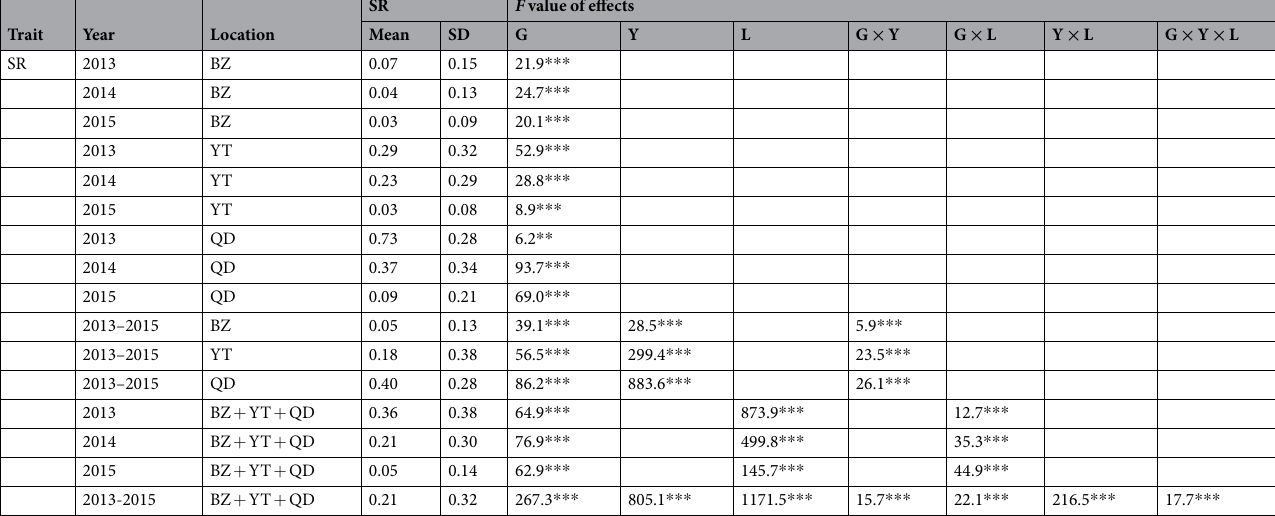
Table 1. Summary of the analysis of variance (ANOVA) of frost tolerance in pea across Binzhou, Yantai and Qingdao, Shandong province, China from 2013 to 2016. SR, survival rate; BZ, YT and QD, Binzhou, Yantai